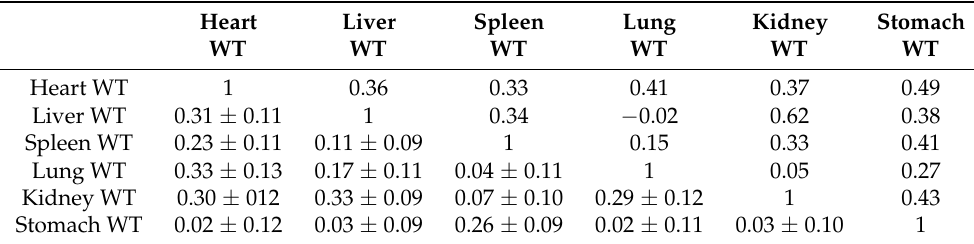
Table 2. Phenotypic correlations (above the diagonal) and genetic correlations (below the diagonal) among organ weight traits within the DLY population.